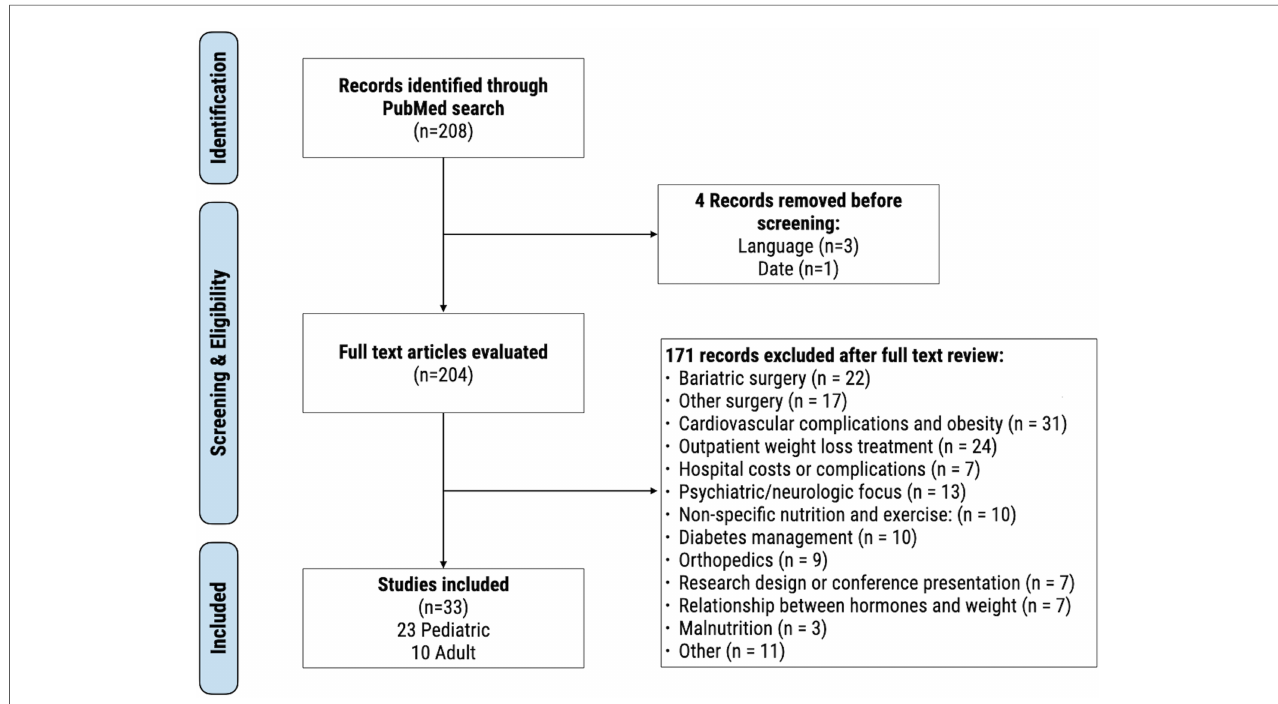
FIGURE 1 Modi fi ed PRISMA fl ow diagram for our literature search results on inpatient, non-surgical, weight loss interventions for adult and pediatric